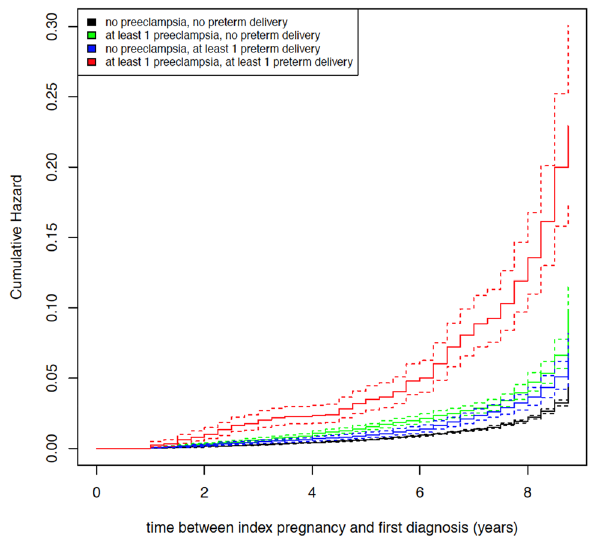
Figure 1. Cumulative hazard plot on risk of any subsequent CKD.